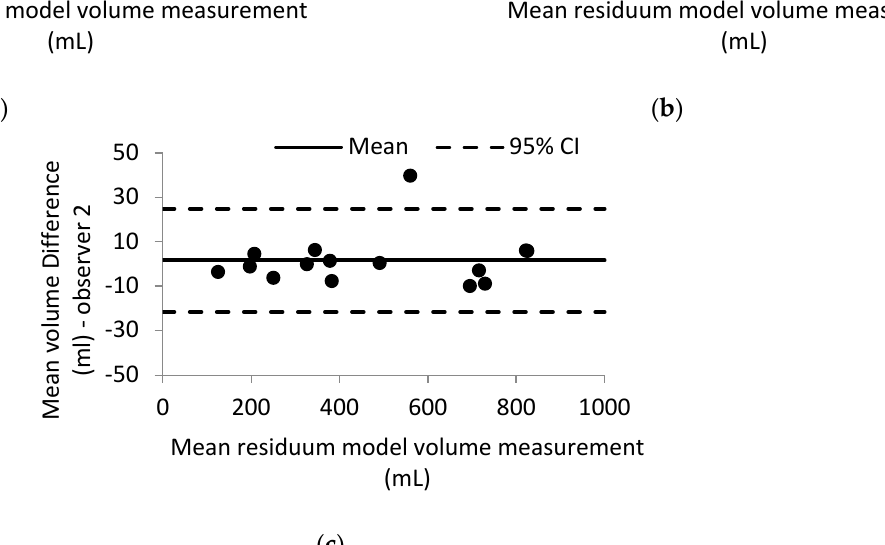
Table 3. Intra-rater and inter-rater reliability of shape measurements.